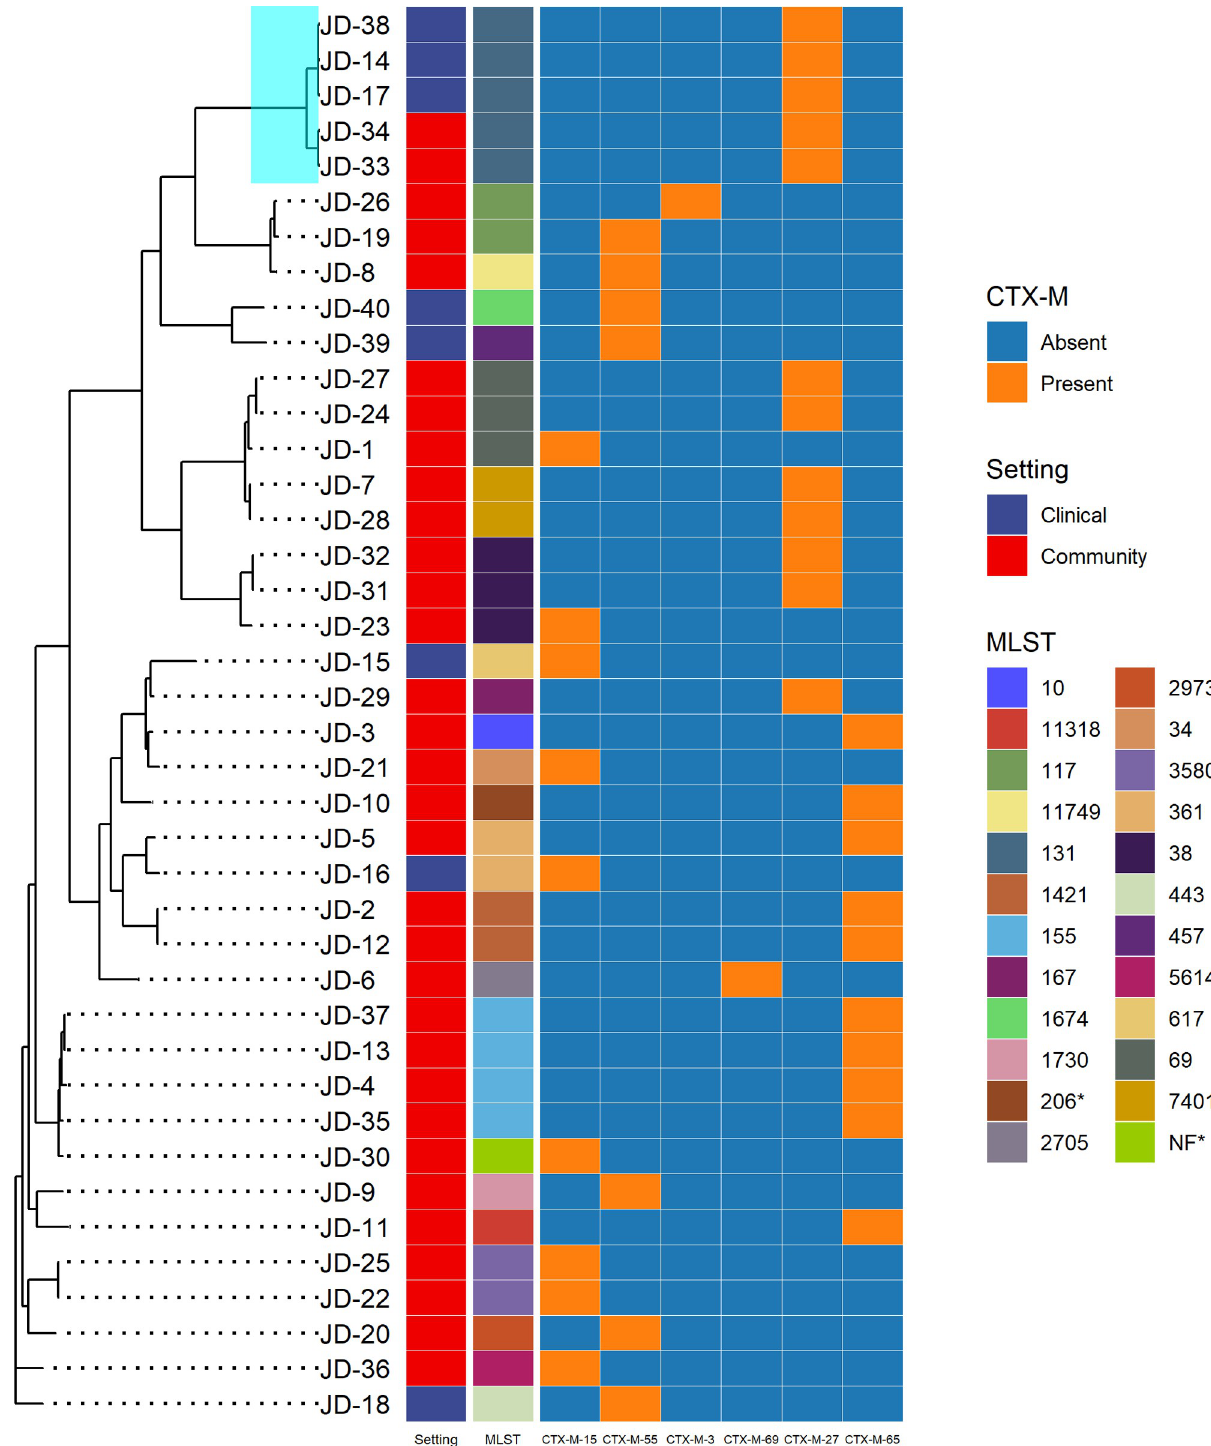
Fig 4. SNP-based pan-genome comparison of ESBL-producing Escherichia coli isolated from Segamat community members (n = 32) and hospital patients (n = 8), annotated with their setting, MLST, and bla CTX-M variant carried. The ST131 clade is highlighted in turquoise.